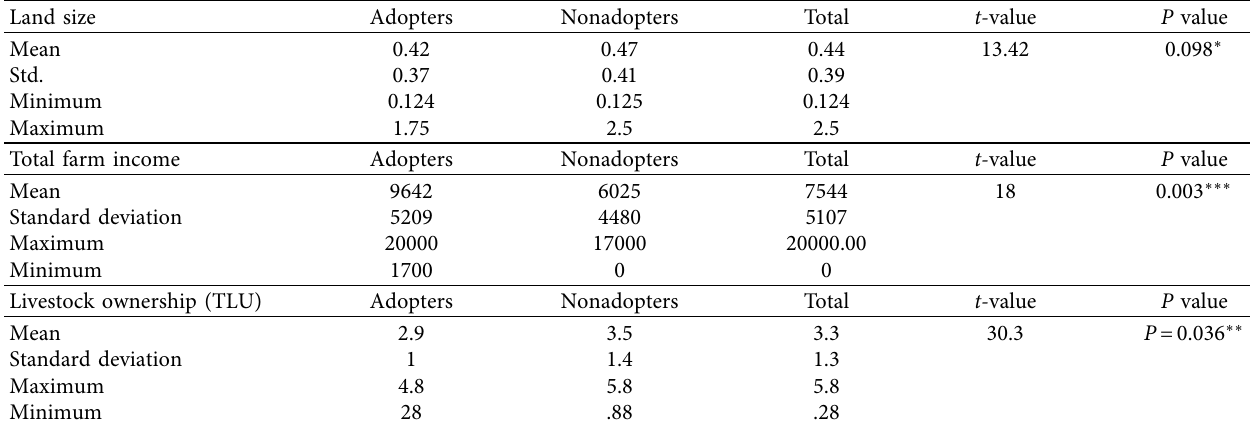
Table 4: Economic